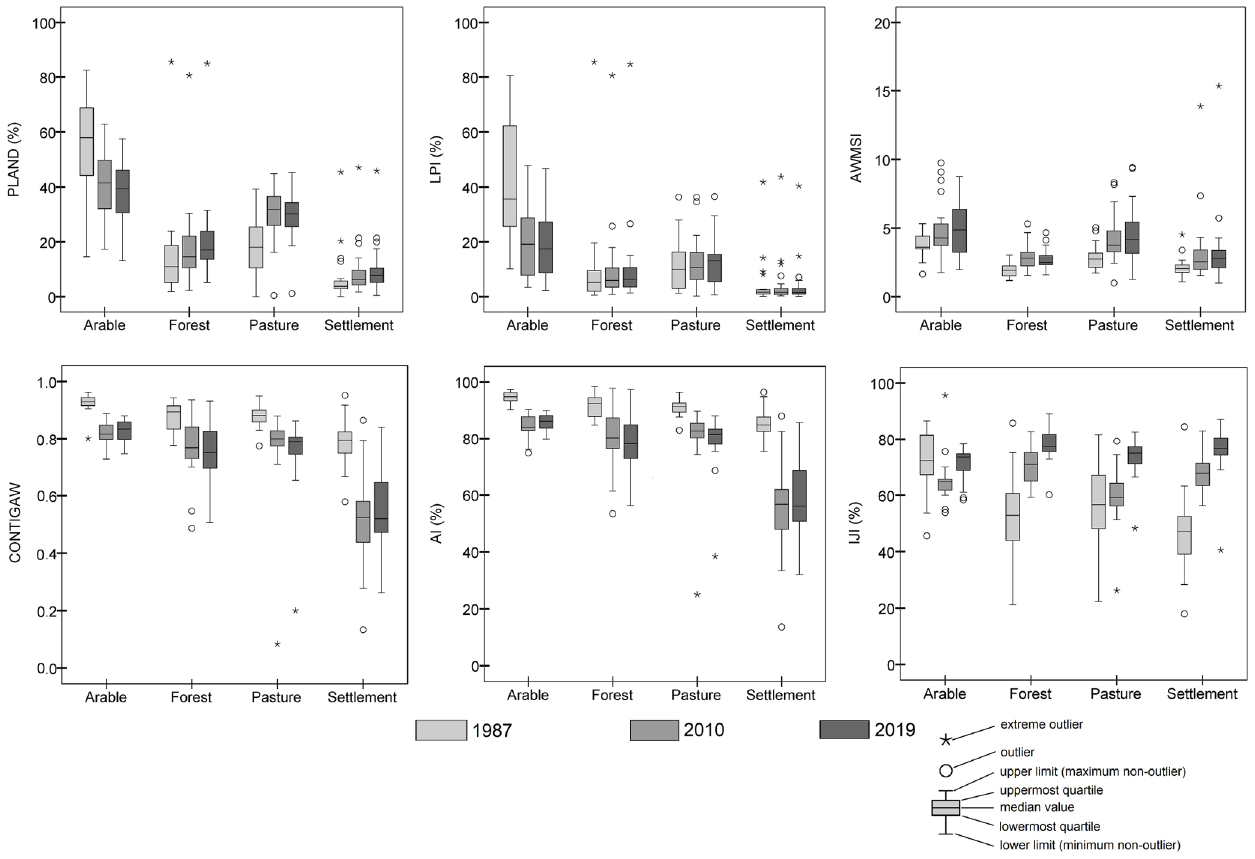
Figure 6. Changes in land use metrics between the years 1987, 2010, and 2019 in the Stör